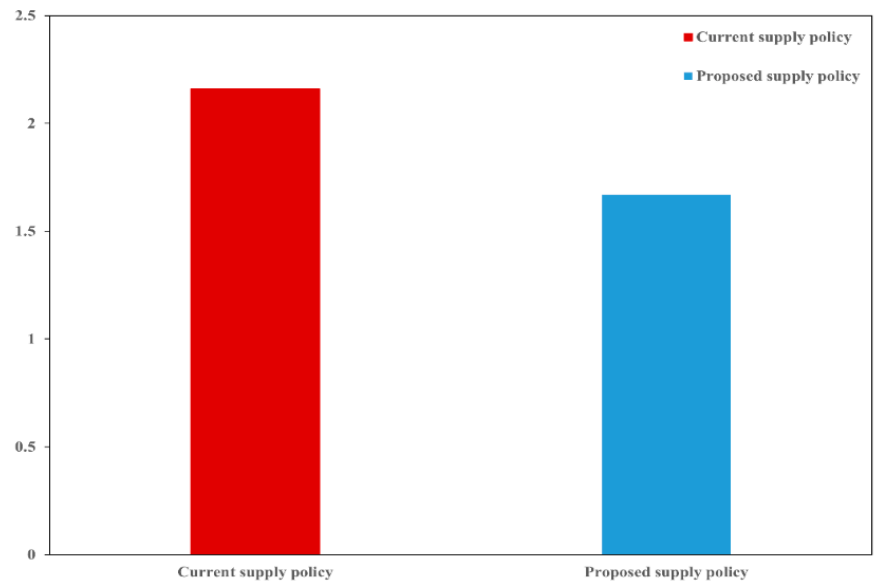
Figure 6. Portfolio assessment using the natural gas security index.